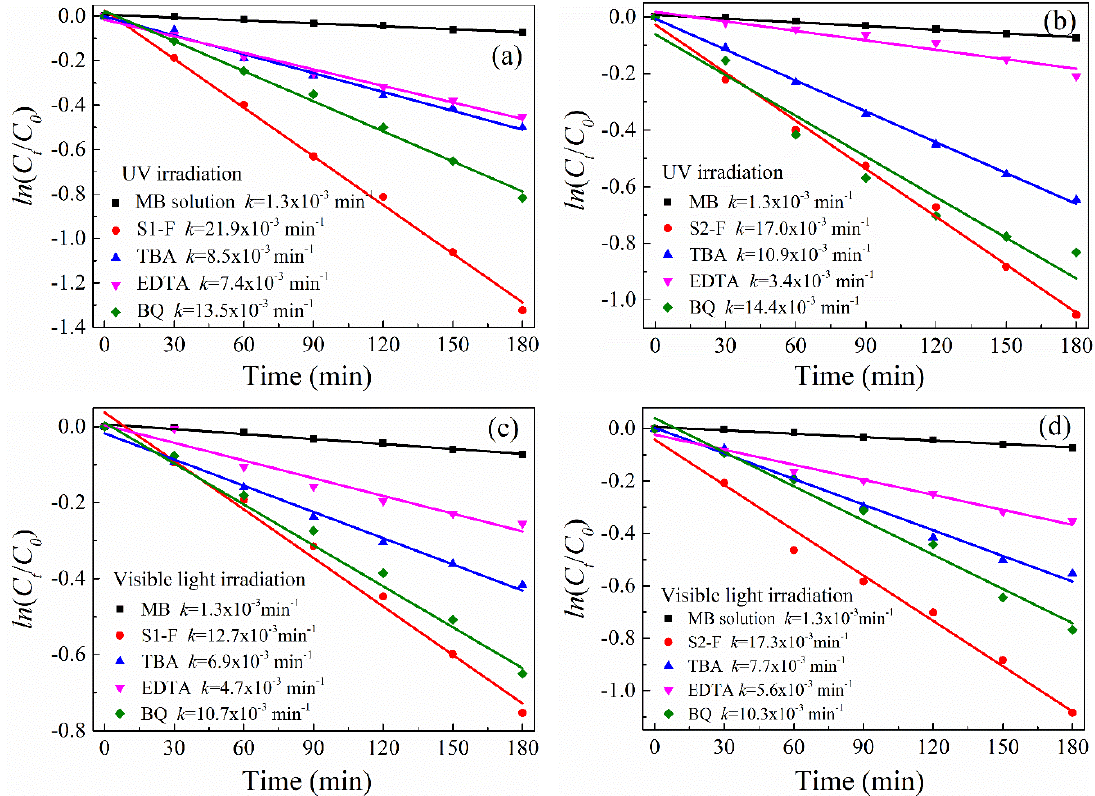
Figure 6. The role of h + in photo-degradation of MB solutions by using the as-modified PET filaments under ( a , b ) UV and ( c , d ) visible light irradiation.